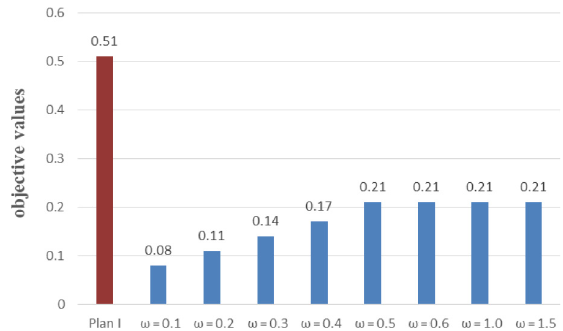
Figure 7 Total objective values under different values of v